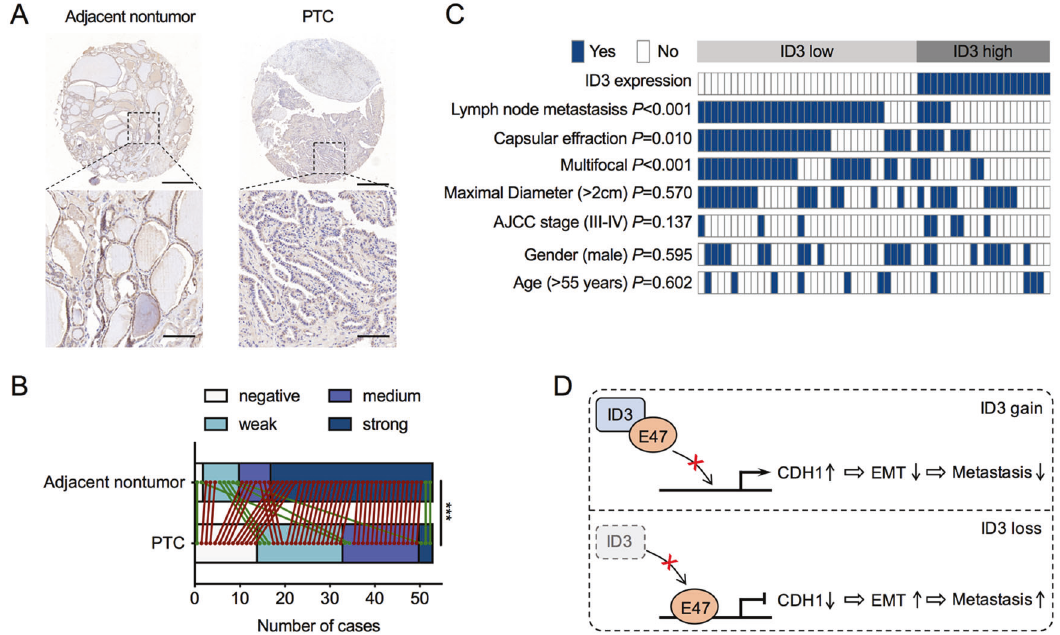
Fig. 5 ID3 protein is repressed in PTC tissues. A Representative image of immunohistochemistry staining for ID3 protein on a tissue microarray constructed from 53 pairs of PTC and adjacent non-tumorous tissue. Scale bars = 500 μ m (top) or 100 μ m (bottom). B Statistical analysis of immunohistochemistry staining results for ID3 from the tissue microarray slide. C comparison of the lymph node metastasis, capsular effraction, multifocal lesions, maximal diameter, AJCC stage, gender, and age among 53 PTC patients according to the ID3 protein expression on a tissue microarray. D A schematic representation of how ID3 loss drives E47-mediated EMT in PTC